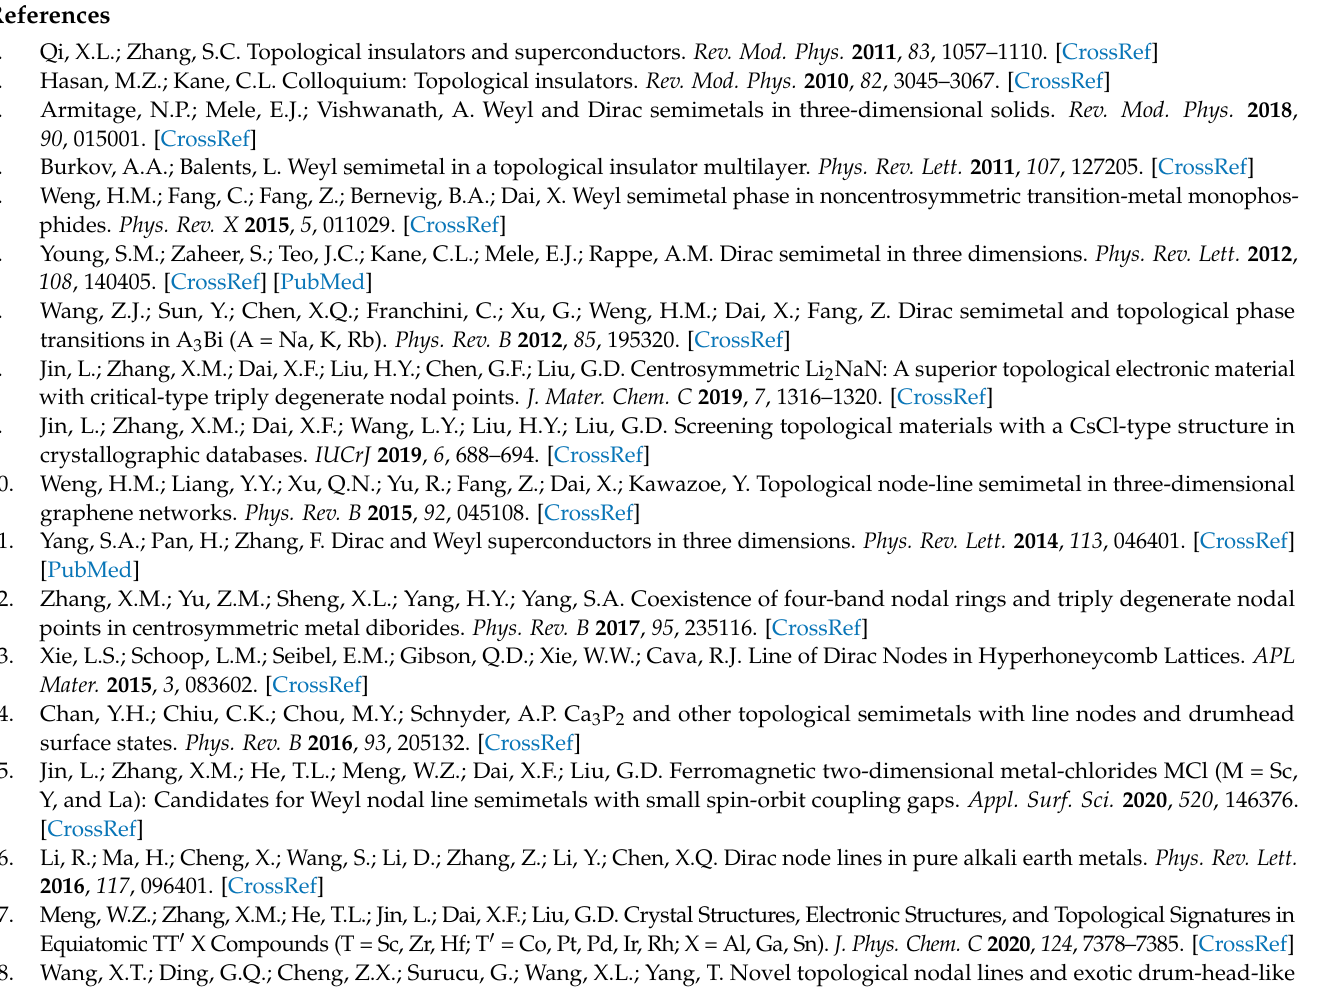
values. Table S1. The energy level of D1, D3, D4, D5, D6 and D7. Table S2. The magnetic of Sn 2 CoS with different DFT + U